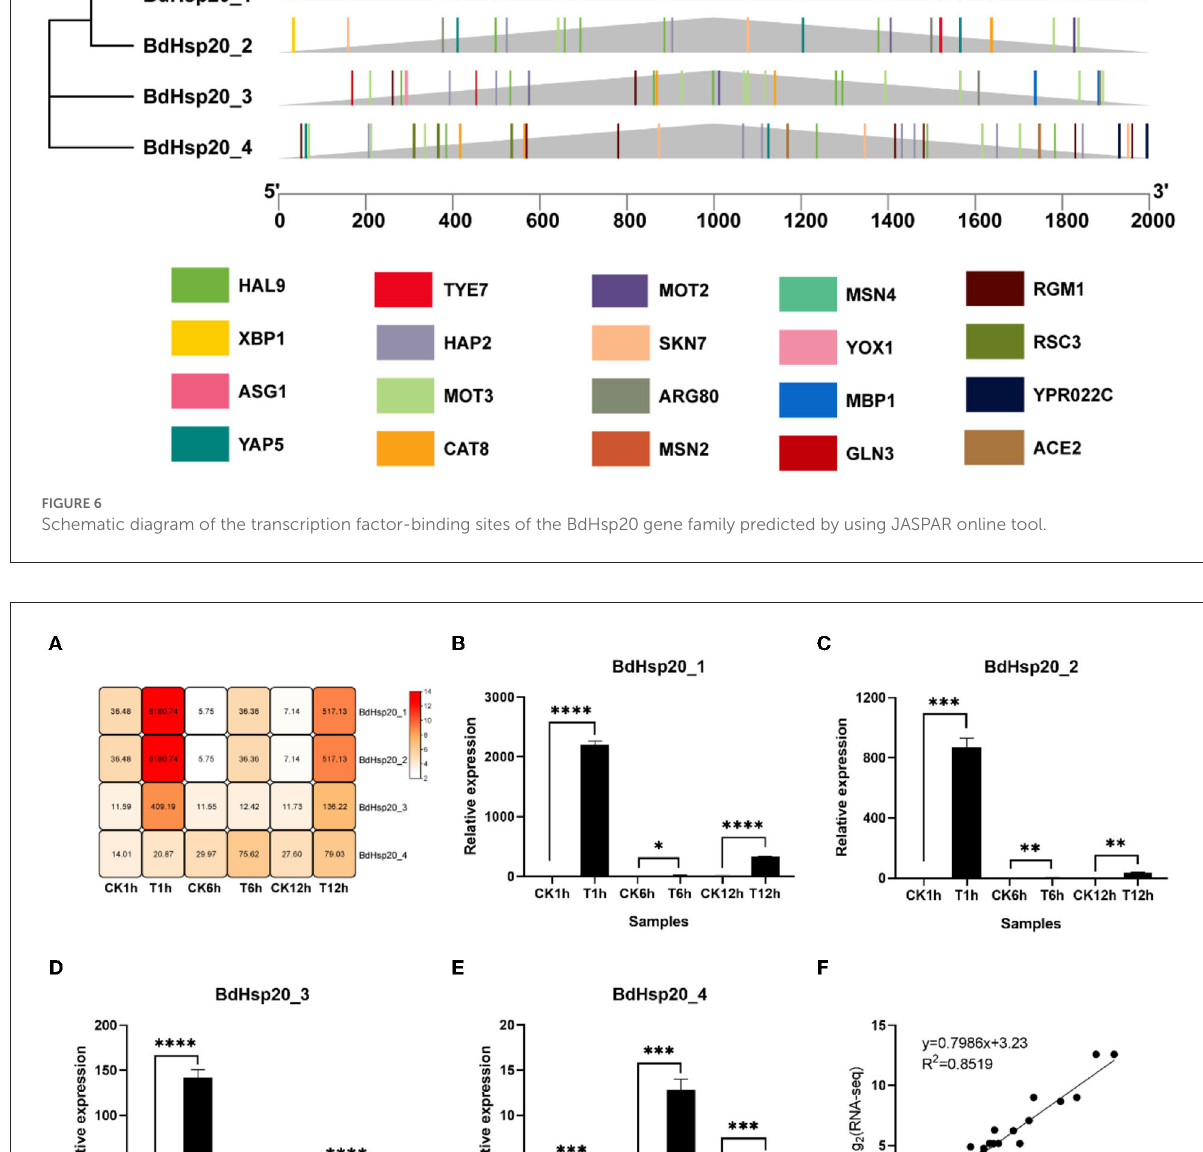
Botrytis cinerea , Neurospora crassa , and Saccharomyces cerevisiae (Wu et al., 2016). In C. trogii , there existed 14 Hsp20 genes (Wang et al., 2021b), which was more than those in the aforementioned fungal species. However, the number of Hsp20